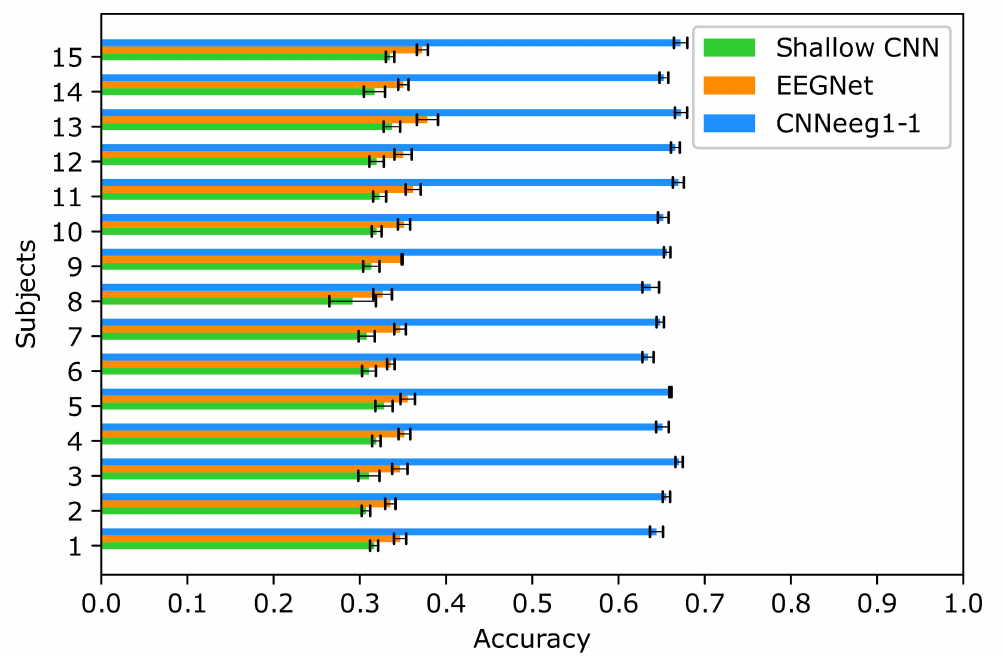
Figure 5. Intra-subject training classification accuracy for the Shallow CNN, EEGNet, and CNNeeg1-1 algorithms using BD1